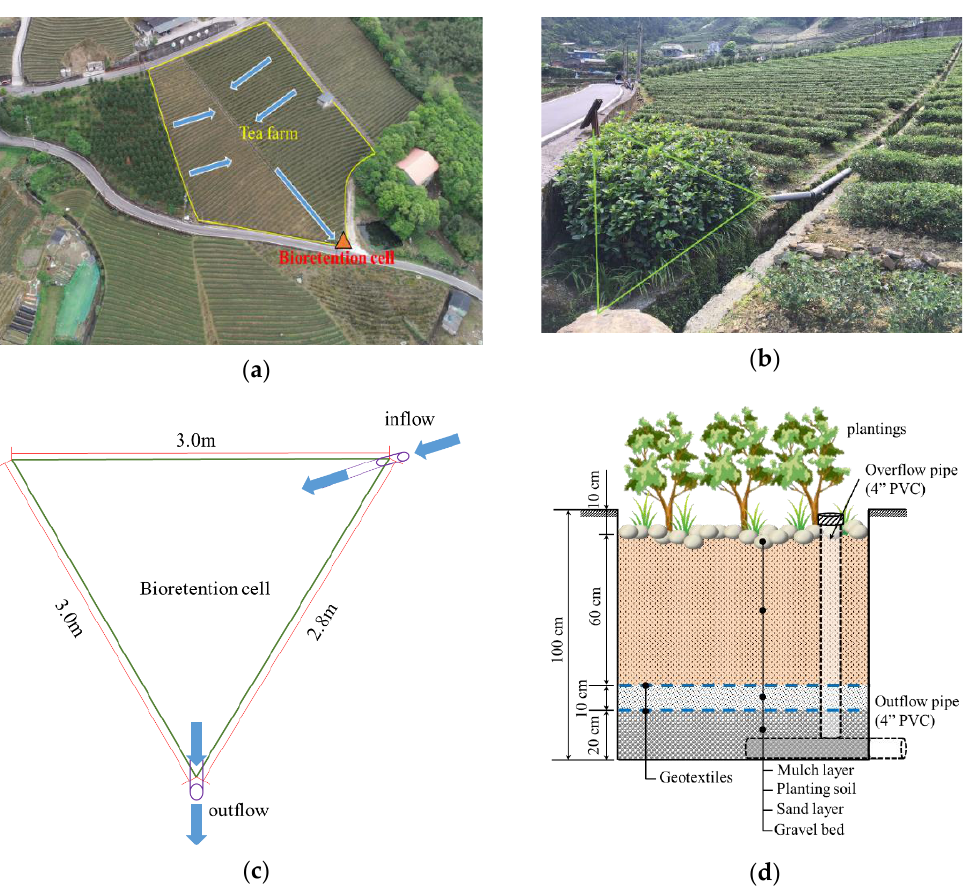
Figure 4. The land use and DEM of the Jinggualiao watershed.